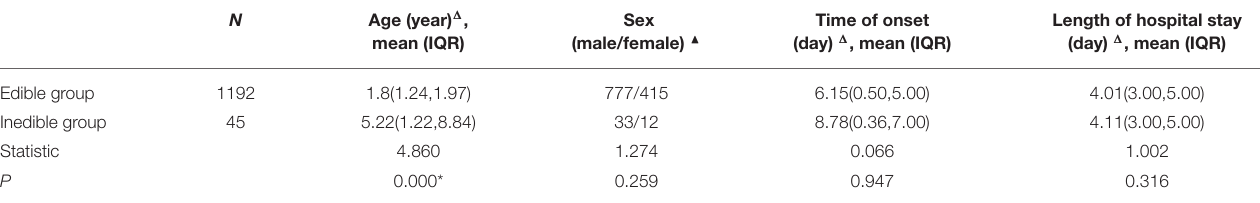
TABLE 1 | Comparison of age, sex, time of onset and length of hospital stay between the edible foreign body group and the inedible